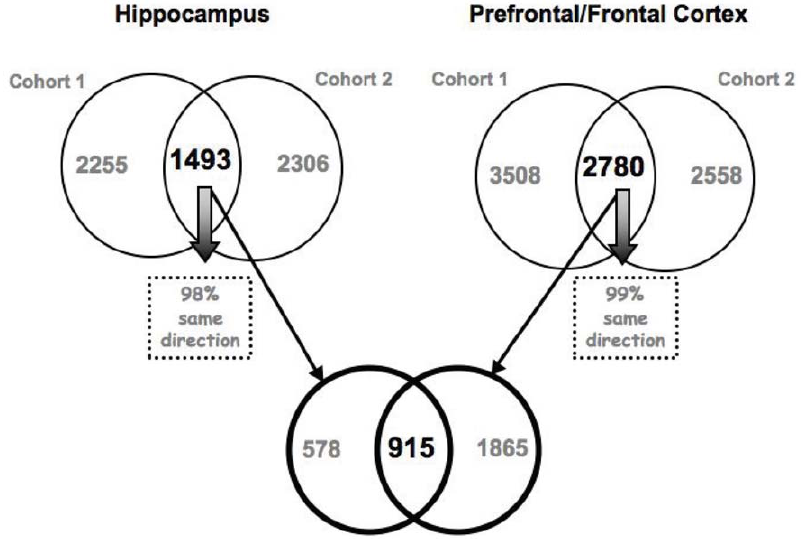
Figure 1. Gene expression summary. Venn diagram showing the number of probesets that were significantly regulated at p-value # 0.05 in HIP and P/FC from cohort 1 and cohort 2. Total number of probesets from each comparison are listed under each cohort, while numbers within the circles represent the breakdown of these figures with respect to each group: number of probesets in common highlighted in bold, while number of probesets specific to each cohort are coloured grey. Concordance in the directionality of response in the common changes is indicated by the arrows.